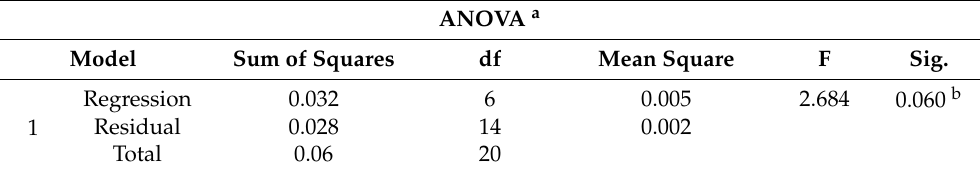
Table 10. ANOVA method for